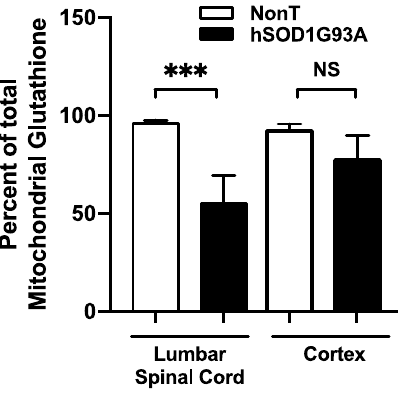
Figure 3. GSH is diminished in mitochondria isolated from G93A mutant hSOD1 spinal cord. Mito ‐ chondria were isolated from NonTg and G93A mutant hSOD1 mice at end ‐ stage (~120 days ‐ old) from lumbar spinal cord and cerebral cortex, and total GSH was measured using HPLC ‐ EC. All measurements were normalized to protein content and represented as a percent of NonTg. Mean ± SEM; NS = not significant, *** p < 0.001, as determined by unpaired Student’s t ‐ test, n = 4.